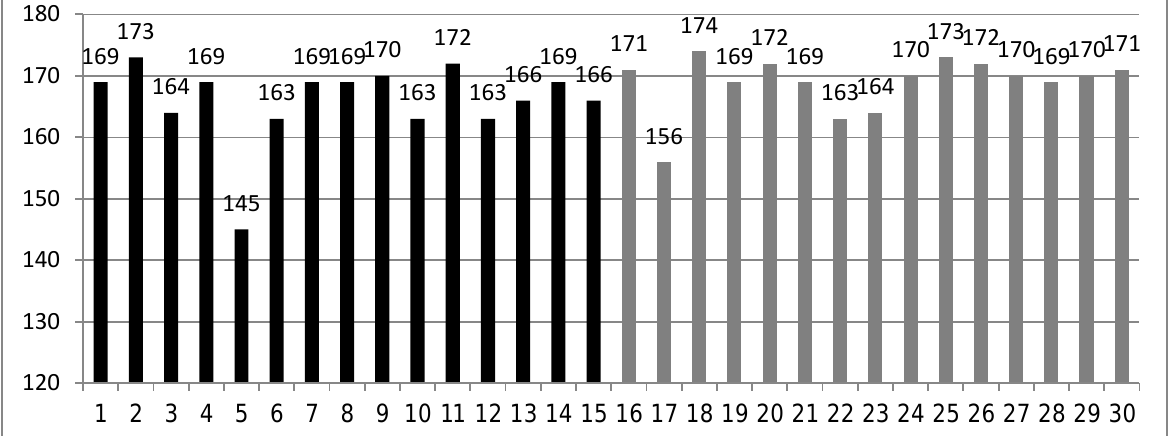
Fig. 7. Scenario “TO BE 2”